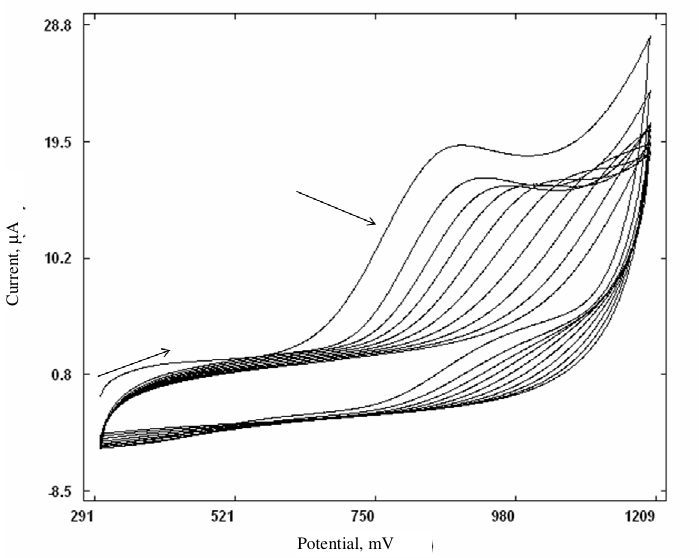
Figure 4 . Cyclic voltammogram of HIBD in the presence of 0.1 M TBATFB in acetonitrile, +0.3 V and +1.2 V potential range using 100 mV s -1 with 10